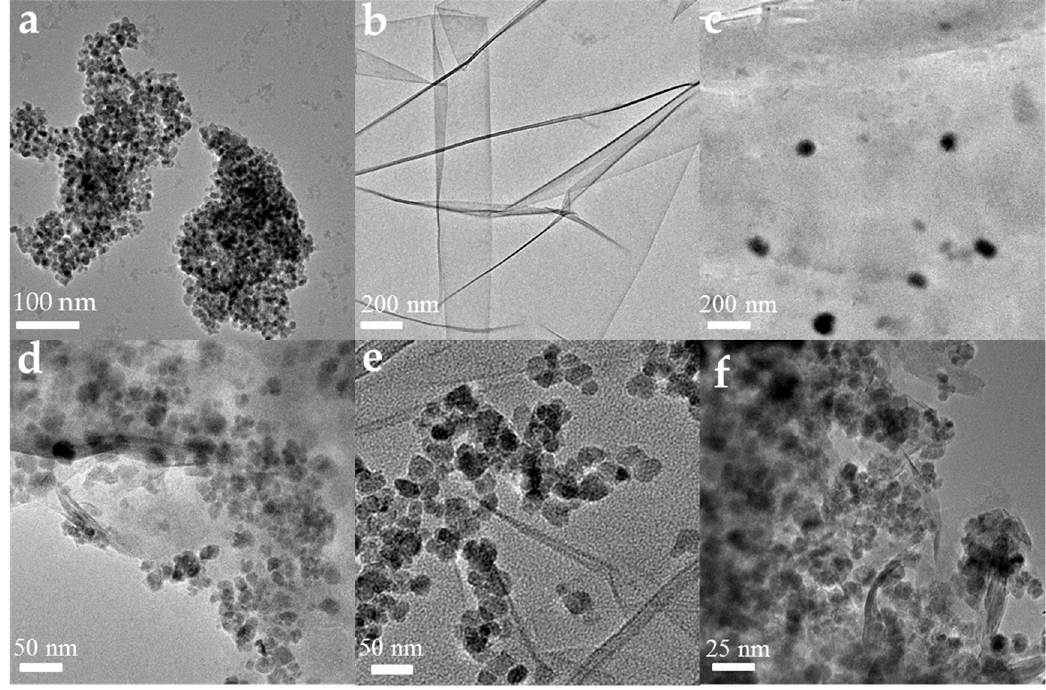
Figure 1. TEM of ( a ) bare Fe 3 O 4 NPs; ( b ) Mt single layer obtained by sonication, different mass ratios of MFH nanocomposites: ( c ) Fe 3 O 4 :Mt = 1:20; ( d ) Fe 3 O 4 :Mt = 1:10; ( e ) Fe 3 O 4 :Mt = 1:4; ( f ) Fe 3 O 4 :Mt = 1:1. Table 1. The specific surface area and porous features of different materials.